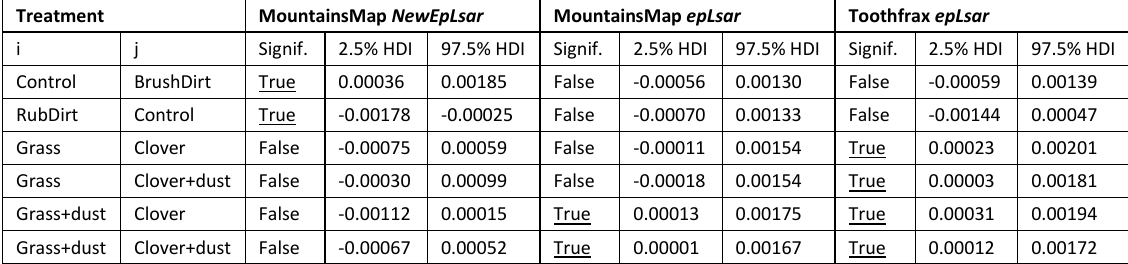
Table 3. Differences in significance for NewEpLsar against epLsar from the two software packages. Only treatment pairs and parameters for which NewEpLsar disagrees with epLsar from at least one software package are shown. For all comparisons, see frame [55] in the notebook "Statistical_Model_NewEplsar_filter_strong" (folder "Python_analysis/code/" on Zenodo). See Table 2 for details on how to read the table and for abbreviations, and text for details on surface parameters and